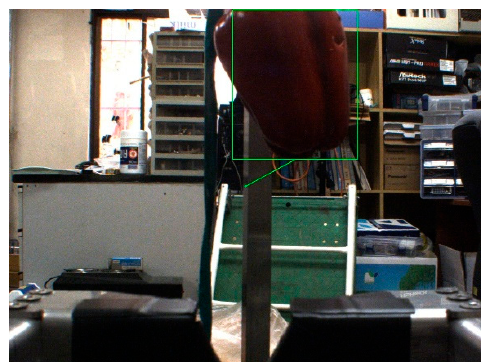
Figure 13. Set-up of control variables.